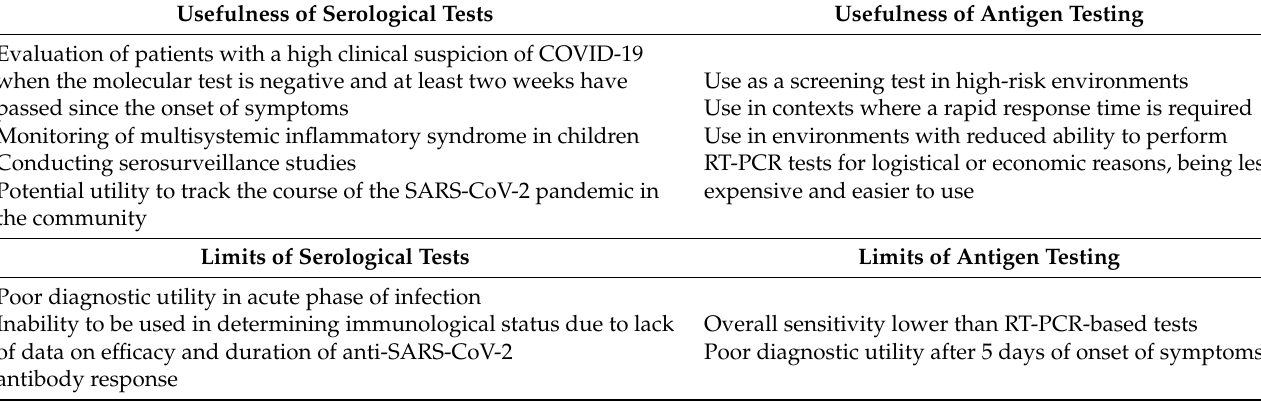
Table 2. Usefulness and limits of antigenic and serological tests in pediatric